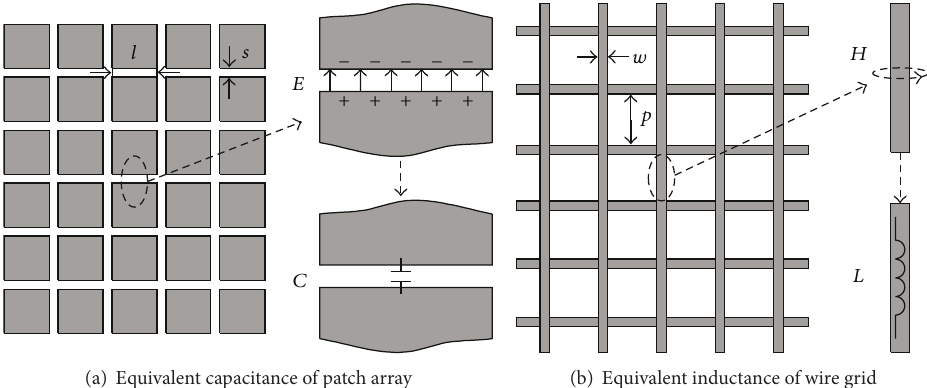
Figure 1: Equivalent analysis of periodic structure.